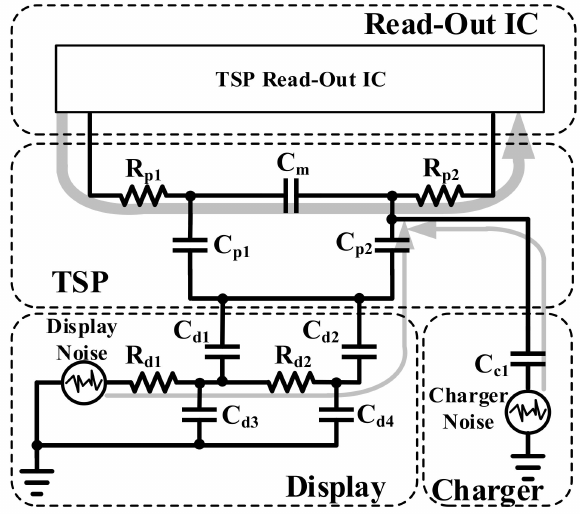
Figure 2. The circuit model and noise sources of the touch system.